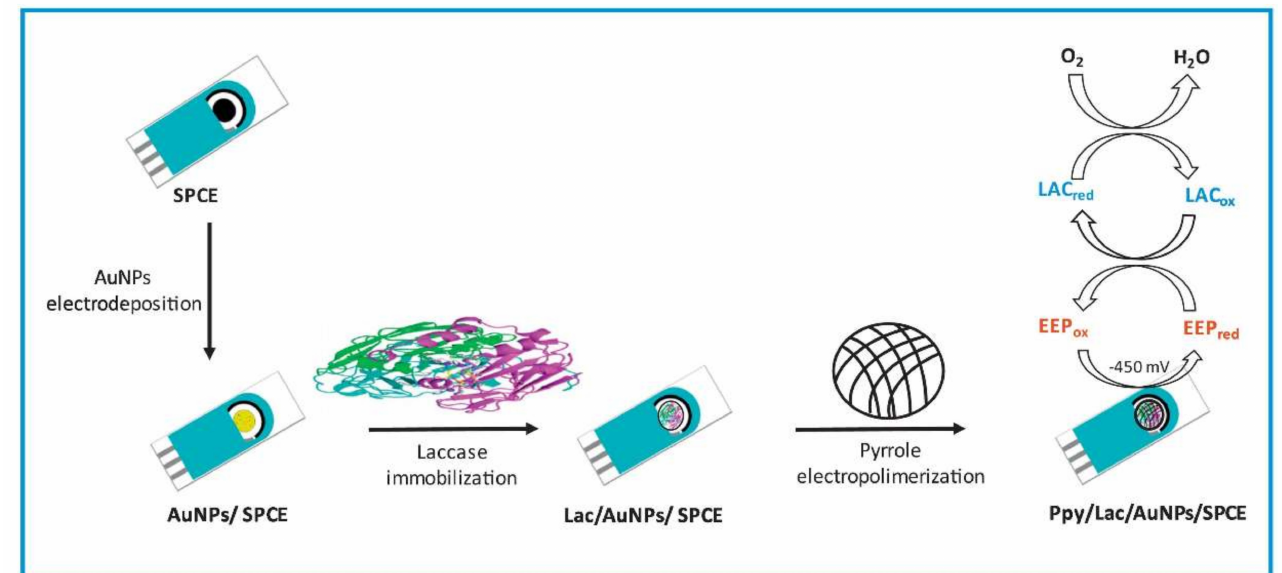
Figure 7. A schematic illustration of the screen-printed carbon electrodes (SPCE) modification with the Ppy/Lac/AuNPs nanocomposite film for the quantification of polyphenols in propolis samples (This image and its caption are adapted from Mohtar et al., 2019 [57] with permission from Elsevier, Amsterdam, The Netherlands (License number